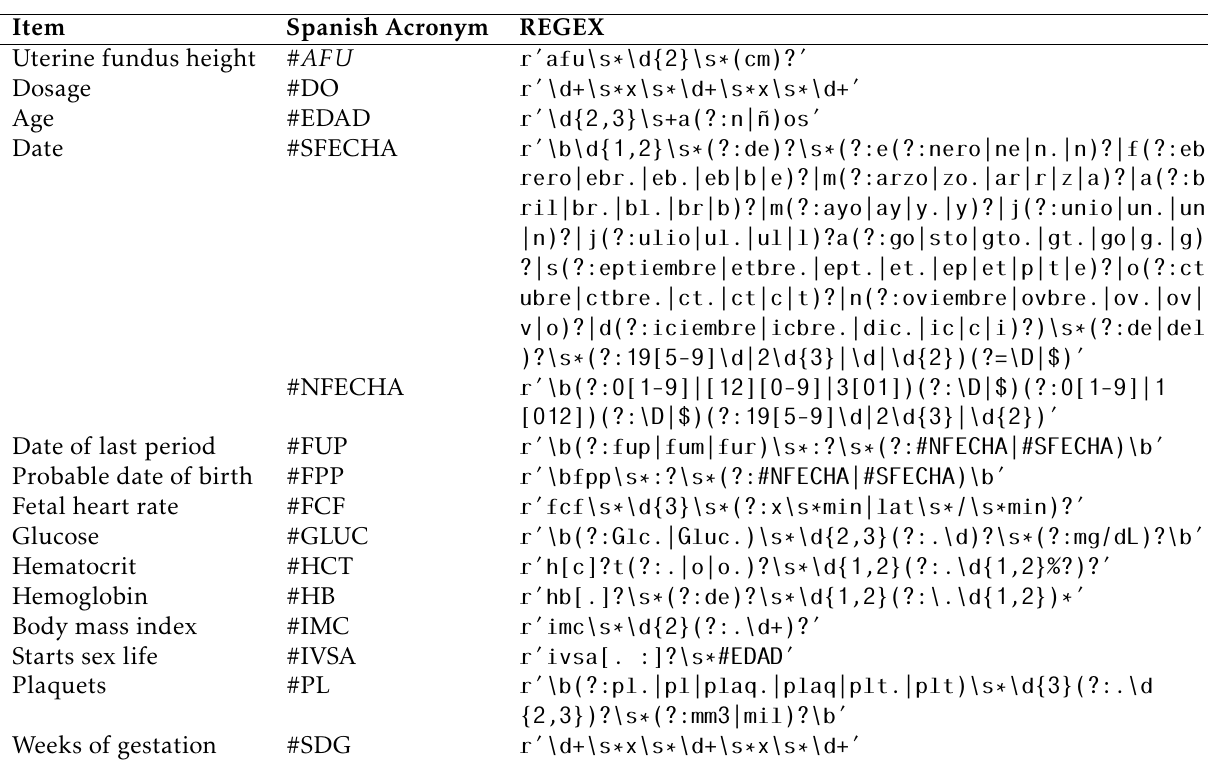
Table 1. UTI regular expressions